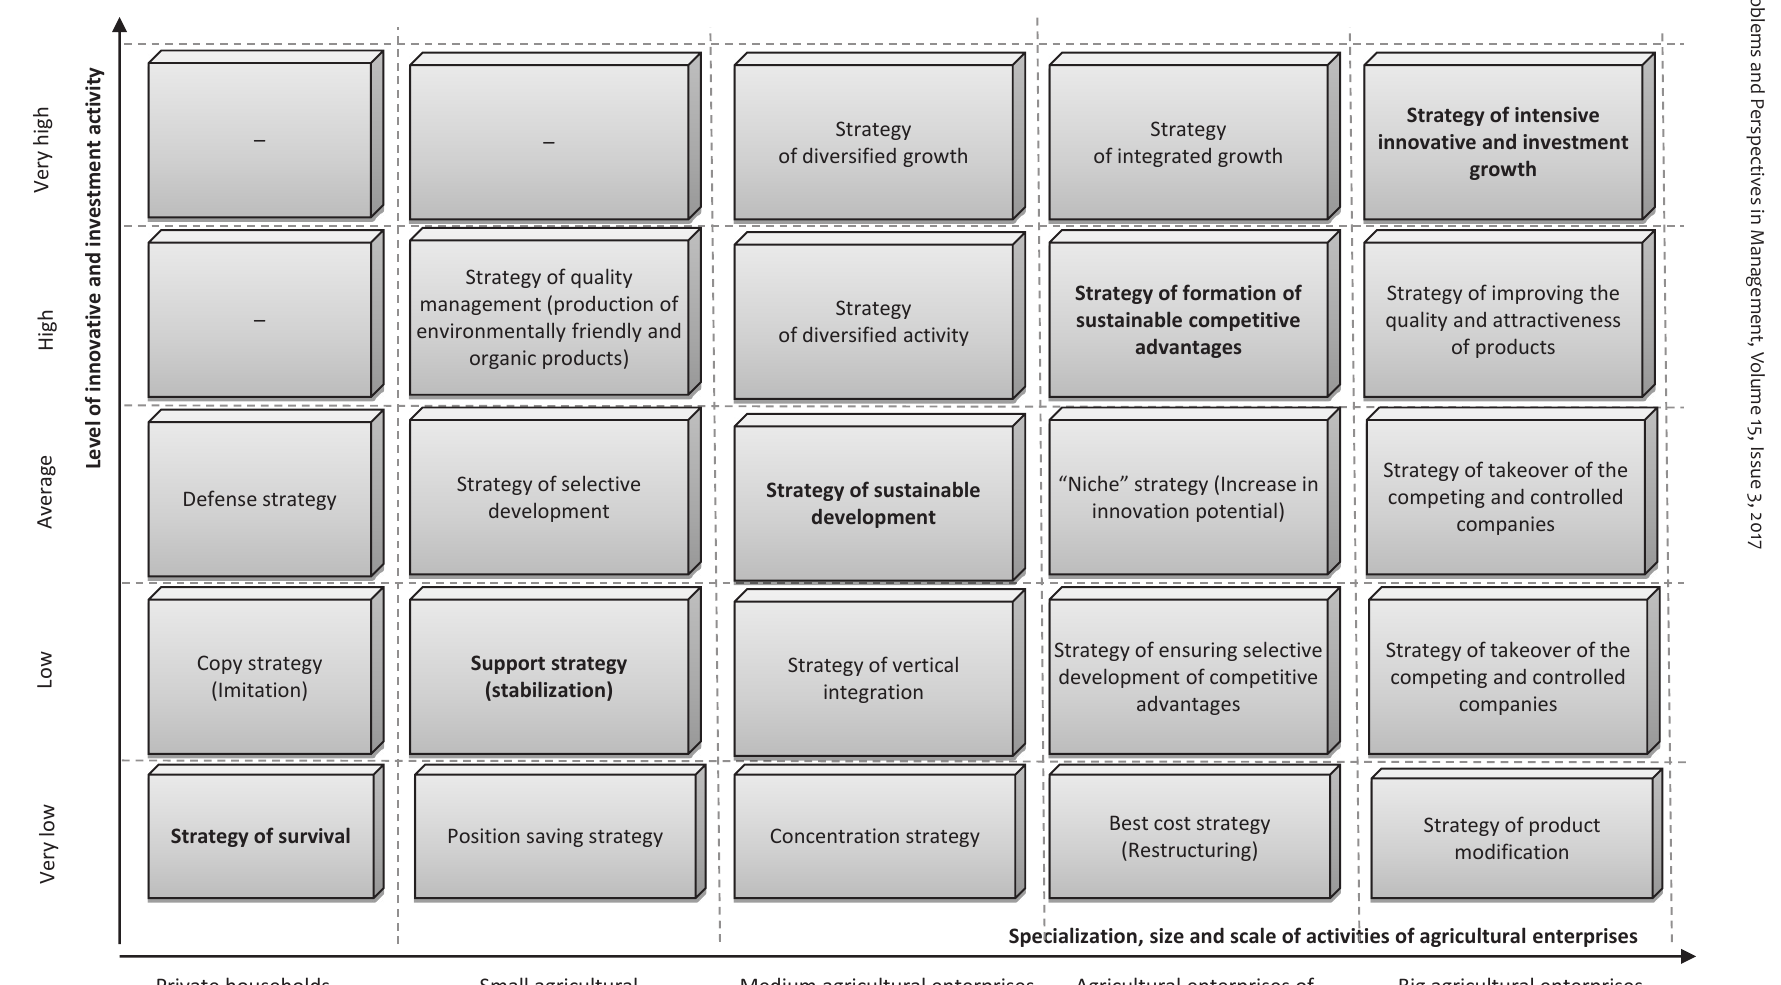
Specialization, size and scale of activities of agricultural